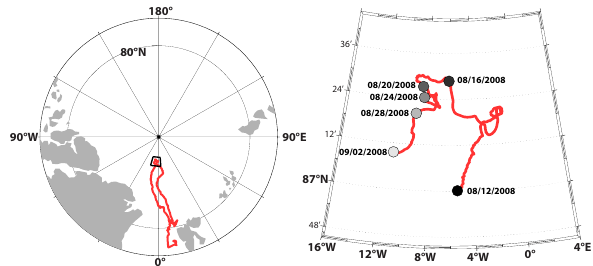
Fig. 1. A map illustrating the path of Oden (red line) during AS- COS. The region of ice drift (black box) is enlarged, and gray-scale points provide the location of the ship on given